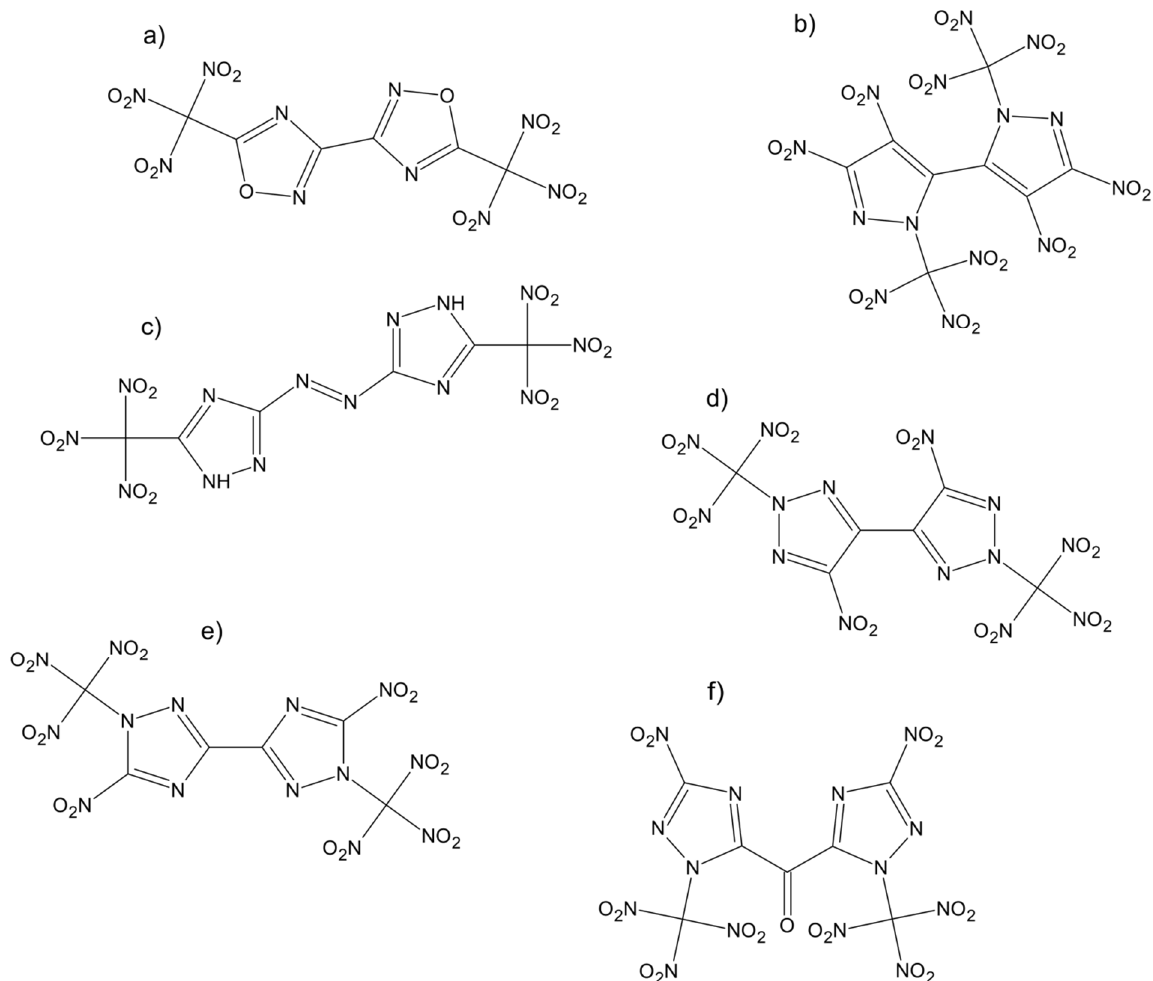
Figure 9. Novel bis-heterocyclic compounds.